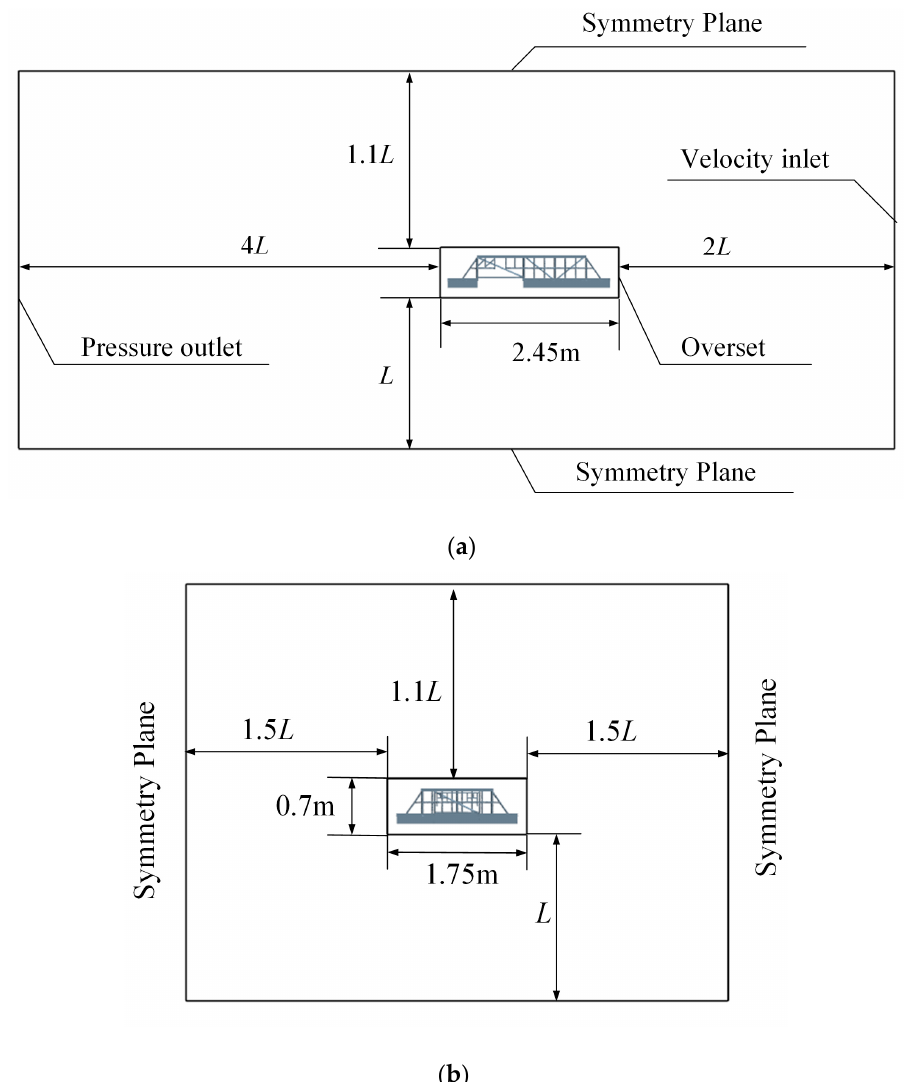
Figure 8. Computational domain and boundary conditions: ( a ) Side view of the computational domain, ( b ) Front view of the computational domain.